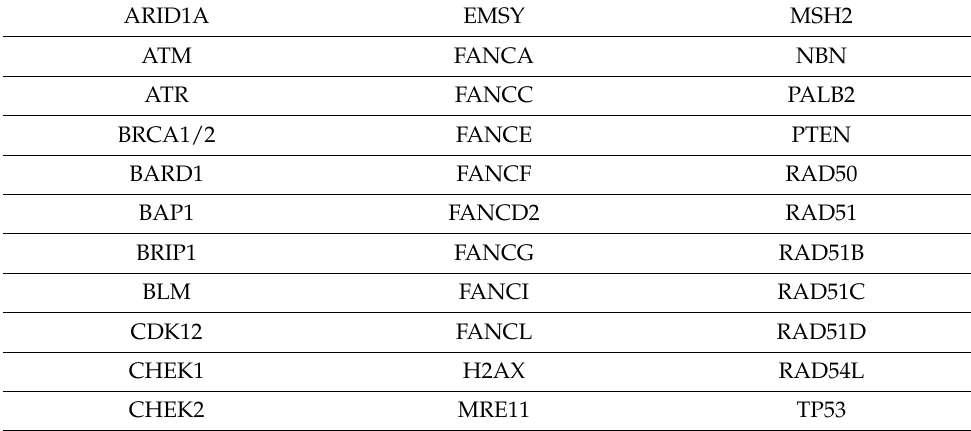
Table 1. Most representative genes involved in the homologous recombination repair pathway [2– 6].